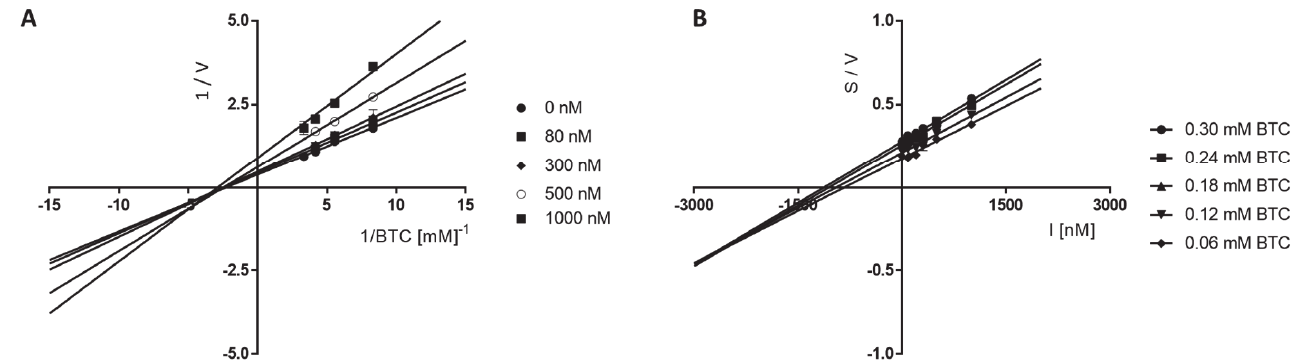
Figure 4. Lineweaver ‐ Burk ( A ) and Cornish ‐ Bowden ( B ) plots illustrating mixed types of eq BuChE inhibition by compound 6 . S = butyrylthiocholine; V = initial velocity rate; I = inhibitor concentration. The Cornish − Bowden plots (S/V vs. I) obtained for 6 displayed a series of converging lines on the same point on or below the x -axis for ee AChE or eq BuChE kinetic studies, respectively, (Figures 3 and 4B) strengthening the noncompetitive ( ee AChE) and mixed ( eq BuChE) mechanism of cholinesterase inhibition.